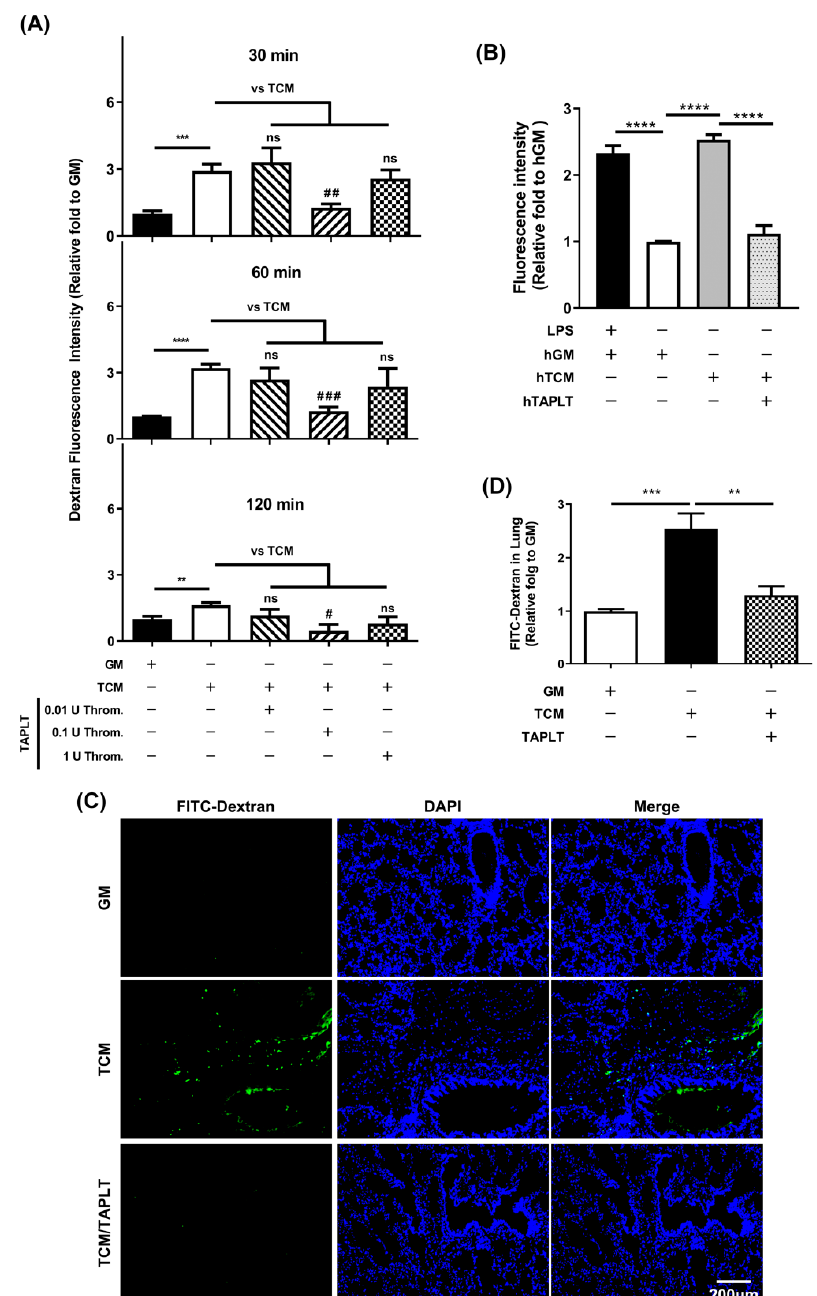
Figure 2. TAPLT ameliorate tumor-driven endothelial permeation. ( A ) TAPLT generated by 0.01 U, 0.1 U, or 1 U thrombin were co-cultured with TCM-treated 2H11 EC for the length of time indicated. Endothelial permeability relative to growth medium (GM) treatment was quantitated by dextran fluorescence intensity. Mean ± SEM, with a total of at least four individual experiments. **: p < 0.01; ***: p < 0.001; and ****: p < 0.0001 by t-test. #: p < 0.05; ##: p < 0.01; and ###: p < 0.001 by ANOVA with TCM treatment alone (“TCM”) as control. ns: not significant. ( B ) Human TAPLT (hTAPLT) were added to TCM-treated human dermal microvascular endothelial cells, HMEC-1, in the same assay setting. Mean ± SEM, with a total of three individual experiments. ****: p < 0.0001 by t-test. ( C ) Endothelial permeation in the lung of BALB/c nude mice was visualized by FITC-dextran signals. The extent of permeation was quantitated for comparison in ( D ). Each column represents 8 animals. Mean ± SEM; **: p < 0.01; and ***: p < 0.001 by t-test